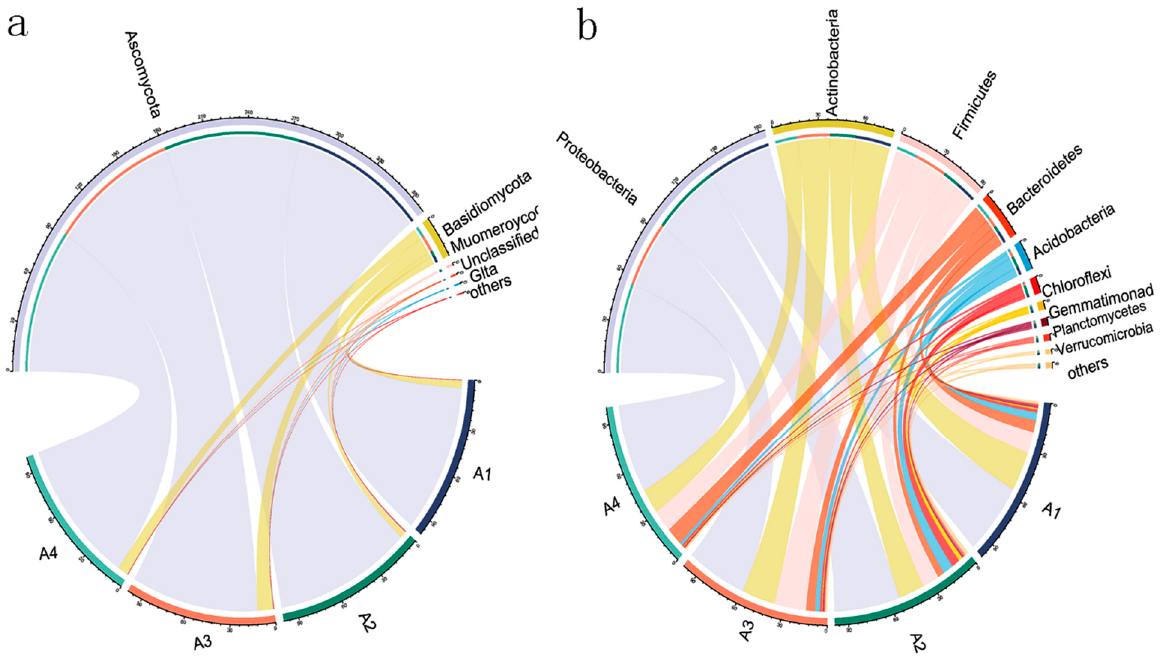
Figure 6. Soil microbiota horizontal community composition and chord diagram. Note: ( a ) represents fungal ʺ phylum level ʺ , ( b ) represents bacterial ʺ phylum level ʺ .